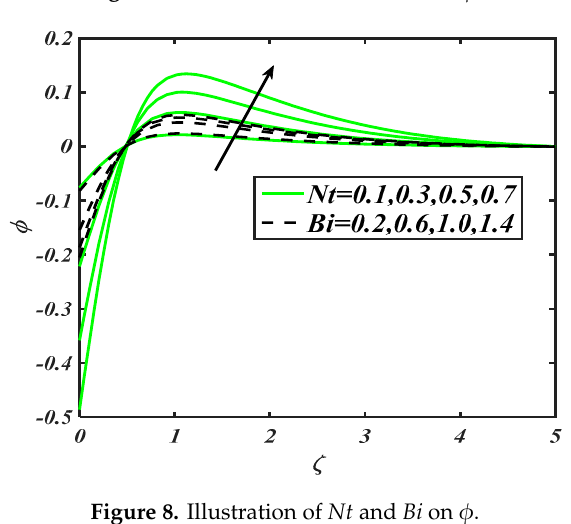
Figure 7. Illustration of Nb and Le on φ .